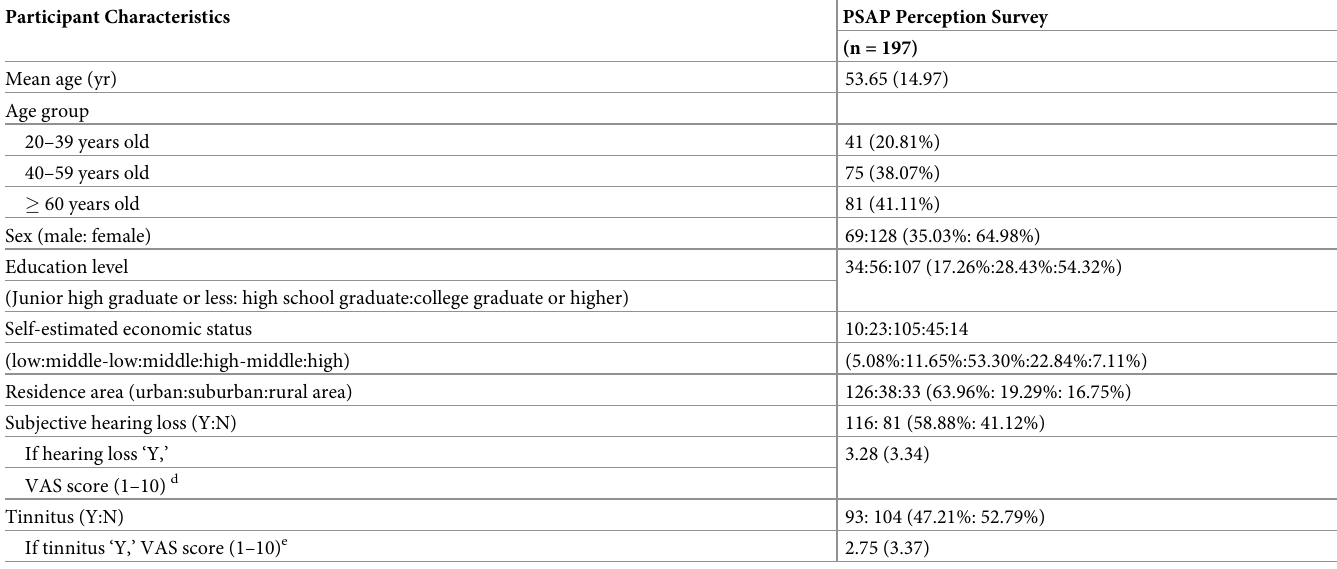
Table 1. Participant